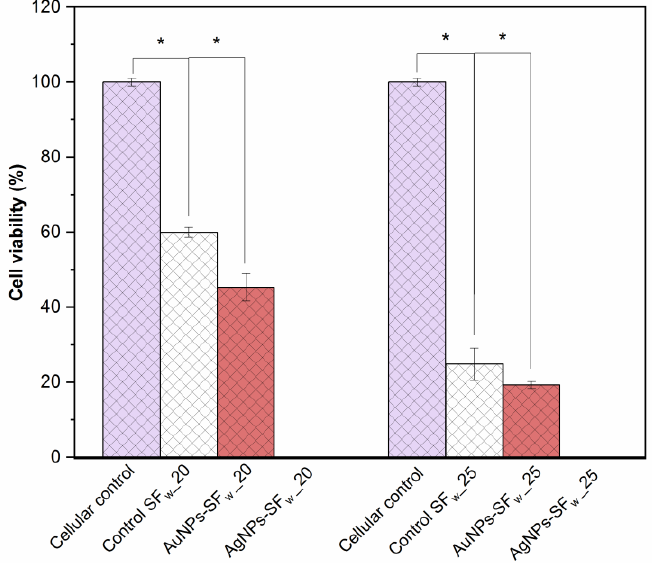
Figure 9. Cell viability of 3T3 fibroblasts on interaction with membranes without or functionalized with the gold or silver nanoparticles. Where _20 represents membranes manufactured at 20 cm and _25 at 25 cm. * indicates statistical significance with p -values < 0.05.